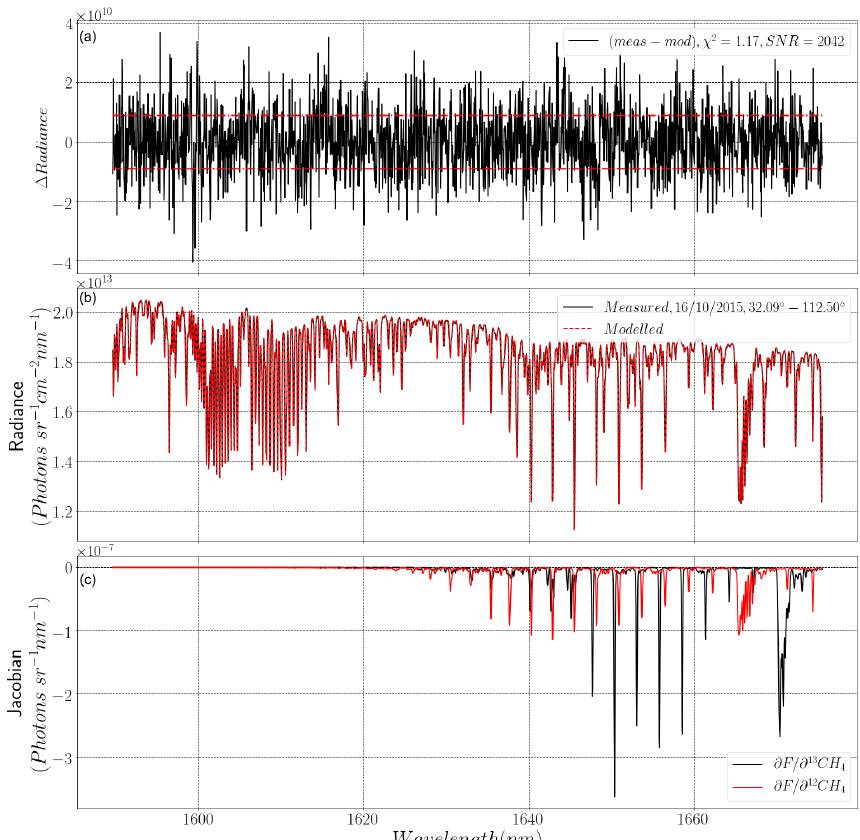
Figure 1. Example spectral fit from RemoTeC, assuming the SWIR1 of S5/UVNS. (b) Example fit at simulated coordinates 32.09 ◦ N 112.5 ◦ W for a day in October 2015 (black line is synthetic “measured” spectra; red dashed line is retrieved modelled spectra). Panel (a) shows the spectral residual between modelled and measured spectra, with the red dashed lines indicating the noise level based on the SNR. Panel (c) shows the total column Jacobians of 12 CH 4 (red) and 13 CH 4